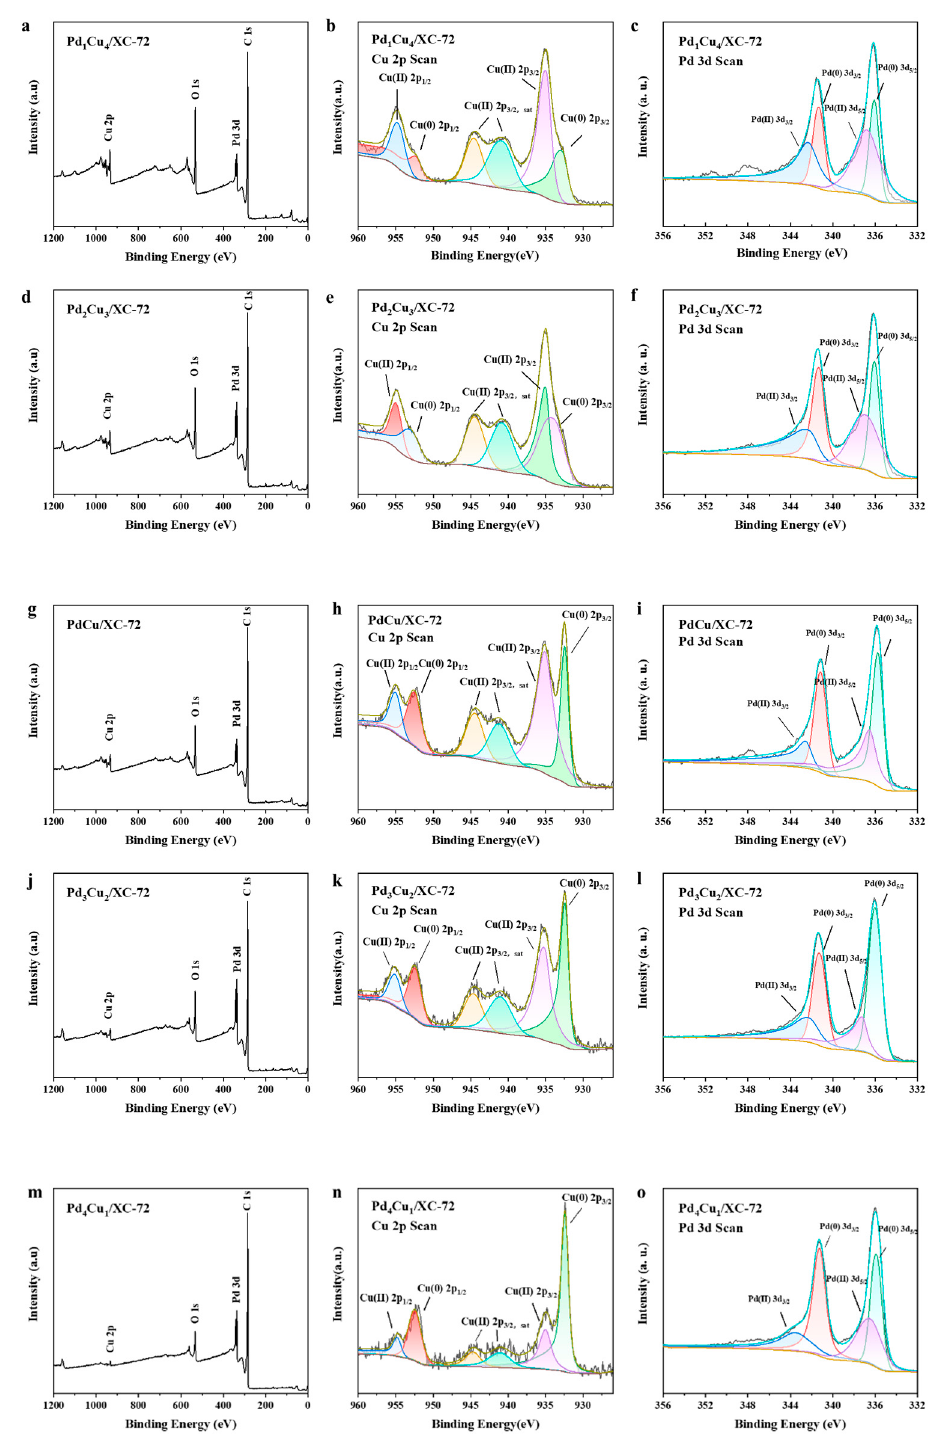
Figure 4. XPS data showing the wide spectra of ( a – c ) Pd 1 Cu 4 /XC-72 wide spectra, Cu 2p, and Pd 3d; ( d – f ) Pd 2 Cu 3 /XC-72 wide spectra, Cu 2p, and Pd 3d; ( g – i ) PdCu/XC-72 wide spectra, Cu 2p, and Pd 3d; ( j – l ) Pd 3 Cu 2 /XC-72 wide spectra, Cu 2p, and Pd 3d; ( m – o ) Pd 4 Cu 1 /XC-72 wide spectra, Cu 2p, and Pd 3d.